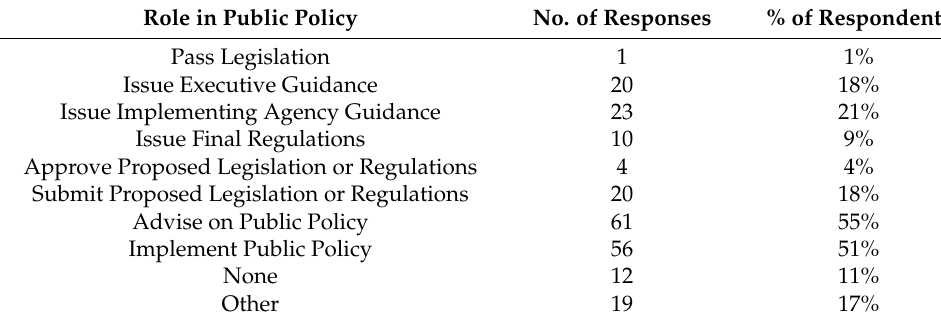
Table 2. Roles in public policy represented.